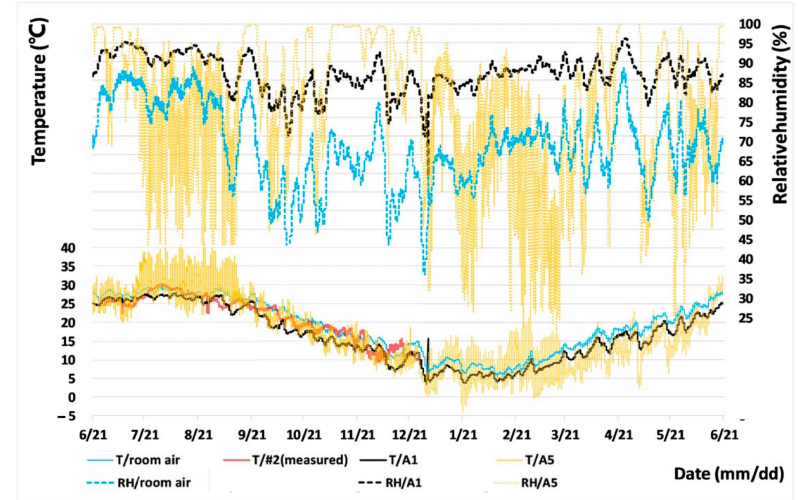
Figure 24. Calculated temperature and relative humidity of the air cells on the interior and exterior surfaces (A1 and